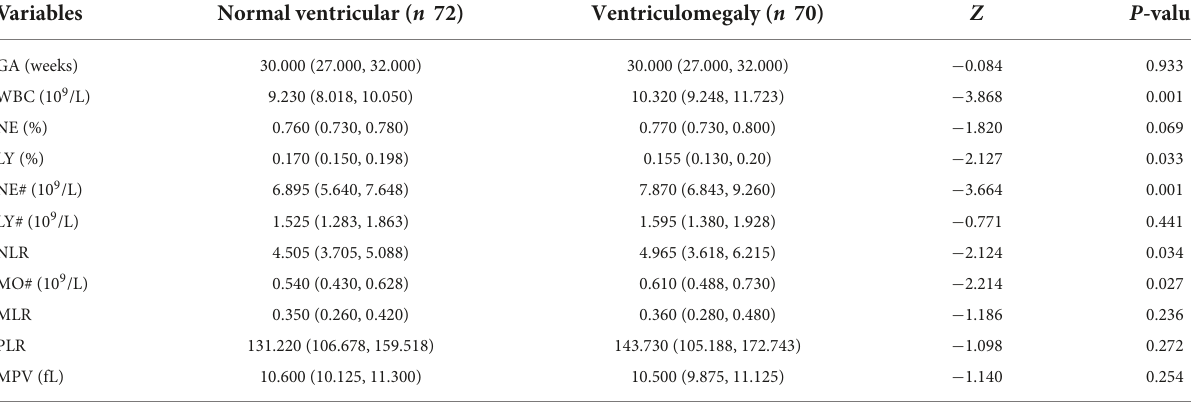
TABLE 2 Comparison of maternal blood parameters in the normal ventricular group and fetal ventriculomegaly (VM)